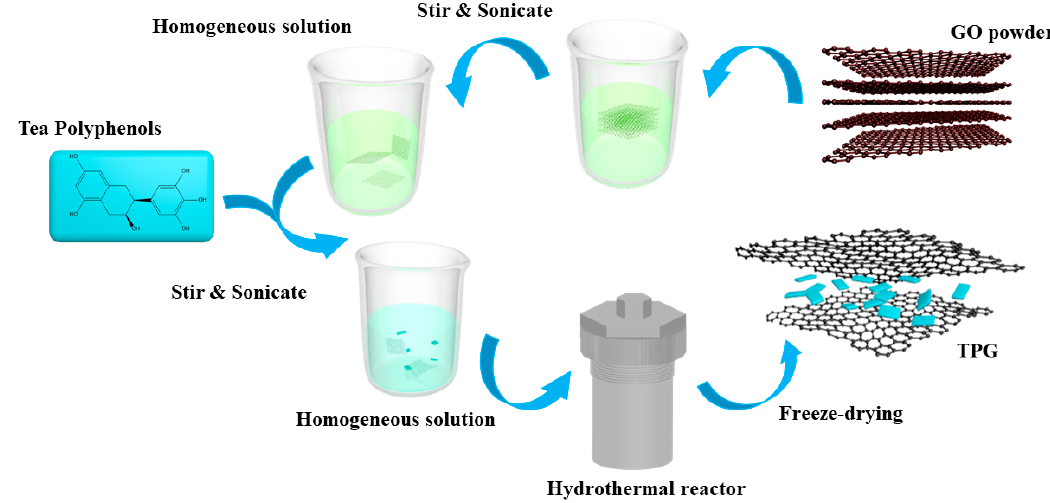
Figure 1. Simple synthetic schematic of tea polyphenol (TP)/graphene (GE).